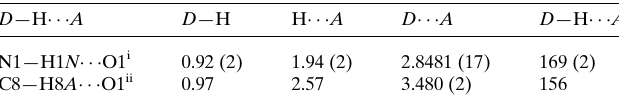
Table 1 Hydrogen-bond geometry (A˚ , (cid:3) ).